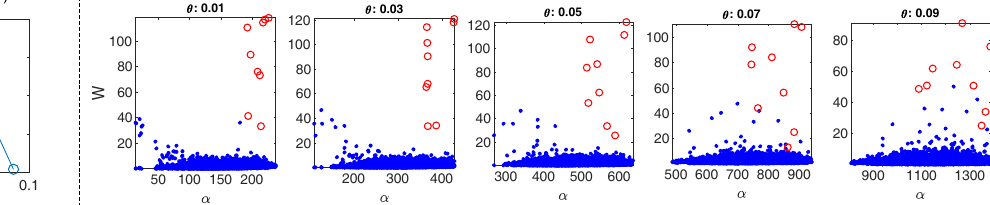
Figure 16. The results of ND-C(3) with different parameter settings on USPS with dimension reduc- tion by t-SNE. ( A ) the ND scores. ( B ) the 2-classification Decision